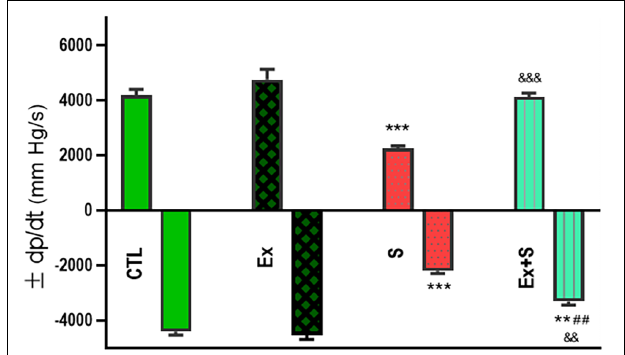
FIGURE 3 | Effects of waterpipe smoke inhalation on positive dP/dt max (+dP/dt max) and negative dP/dt max (-dP/dt max) in experimental groups. CTL, control group; Ex, group subjected to exercise training for 8 weeks; S, group subjected to waterpipe tobacco smoke inhalation for 8 weeks; Ex + S, group subjected to exercise training and waterpipe tobacco smoke inhalation for 8 weeks. The results are presented as mean ± SEM, n = 7. ** P < 0.01; *** P < 0.001 vs. CTL; ## P < 0.01 vs. S; && P < 0.01; &&& P < 0.001 vs. Ex.